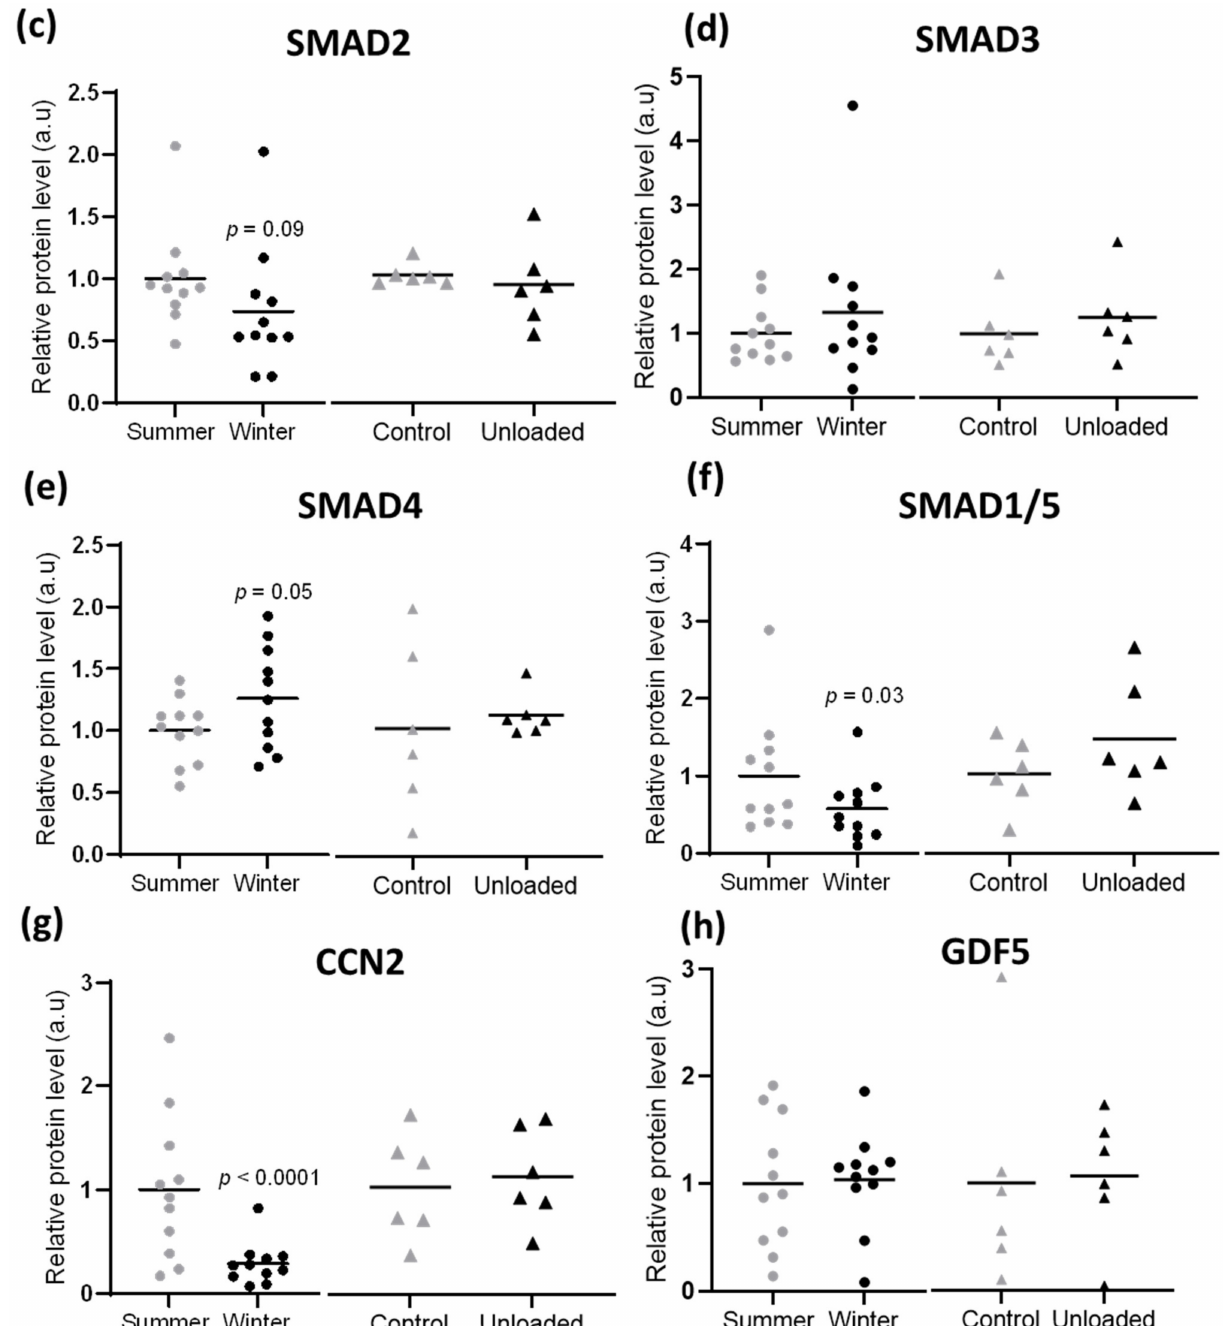
Figure 6. Hibernation induces changes in TGF- β and BMP components at protein level. Protein levels for total SMAD2/3, SMAD1/5, SMAD4, CCN2, and GDF5 were assessed by Western blots ( a ) in the vastus lateralis muscle of brown bears during summer (S) and winter (W) and ( b ) in the soleus muscle of control (C) and unloaded mice (U). Representative western blots are shown for three couples of bears and mice. ( c – h ). Data are presented as individuals’ values with mean bars ( n = 11 bears/season, the same individuals were sampled and analyzed in summer and winter, and n = 6 mice per condition). Gray and black dots are for muscles of bears, in summer and winter, respectively, and gray and black triangles are for control and unloaded muscle of mice,